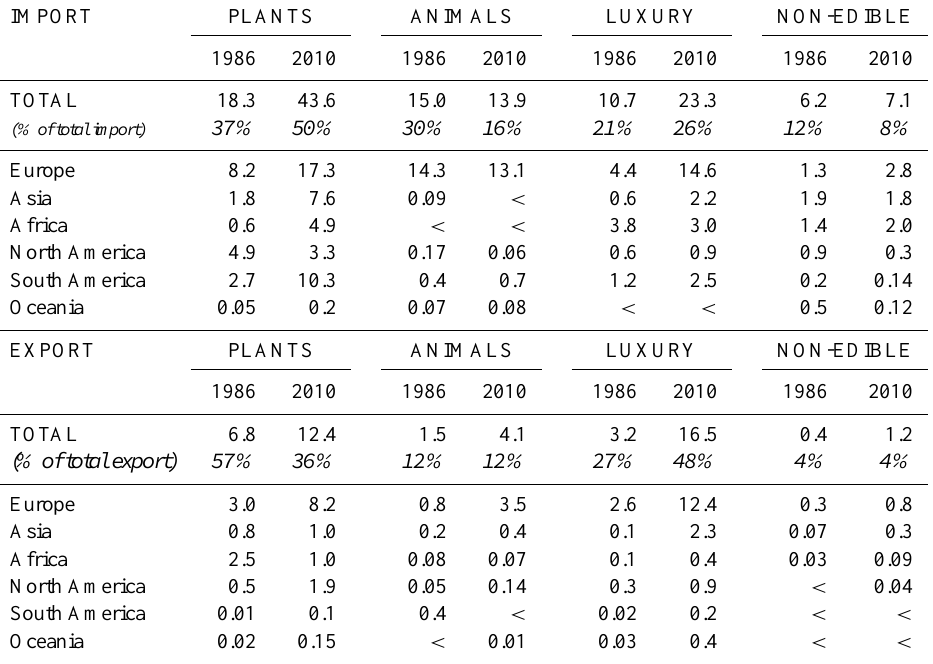
Table 3. Volumes of virtual water imported/exported by Italy in 1986 and 2010 subdivided into categories of exchanged goods (in km 3 yr − 1 ) from/to different world regions. Percentages (in italic) are calculated with respect to the total import (and export) of each year; “ < ” indicates volumes lower than 0.01km 3